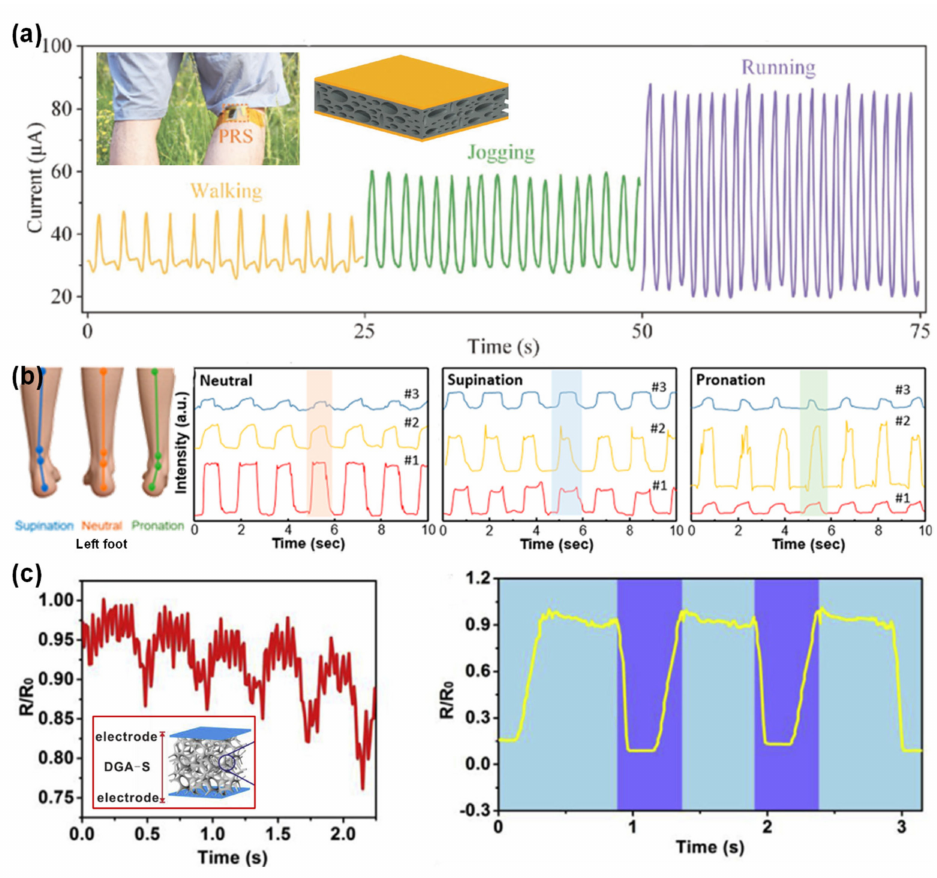
Figure 15. E-skins applied to detection of walking or other related patterns. ( a ) Output of the e-skin developed by Haixia Zhang and co-workers in 2017 for walking, jogging, and running, with the insets showing the placement of the e-skin in the back of the leg and an illustration of the e-skin [232] ( © 2020 WILEY-VCH Verlag GmbH & Co. KGaA, Weinheim, Germany). ( b ) Output of the e-skin developed by Tian-Ling Ren and co-workers in 2018 for the discrimination of neutral, supination, and pronation gait patterns (reprinted with permission from [168]. Copyright 2018 American Chemical Society, Washington, WA, USA). ( c ) Output of the e-skin developed by Jing Li and co-workers in 2018 for the detection of the motion caused by the Restless Legs Syndrome (left) or walking (right), with the inset illustrating the e-skin [195] ( © 2020 Elsevier Ltd. All rights